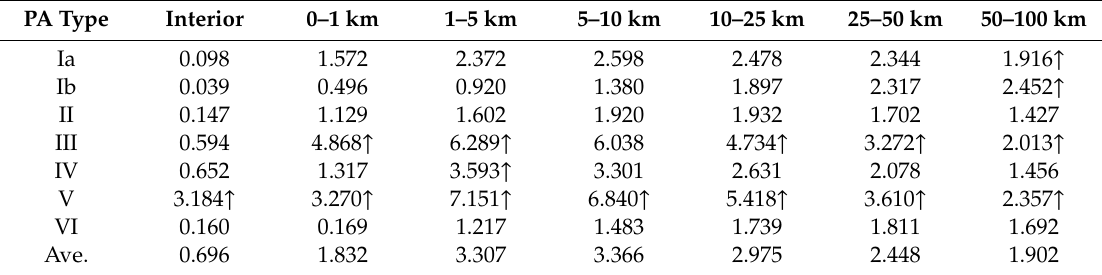
Table 2. NTL level of interior and bu ff er zones for the seven types of